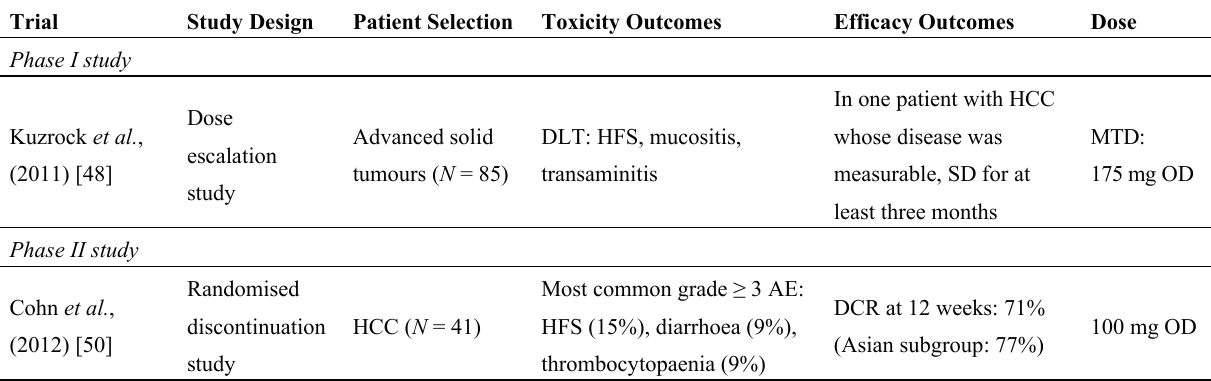
Table 4. Selected phase I and II clinical trials of Cabozantinib monotherapy in